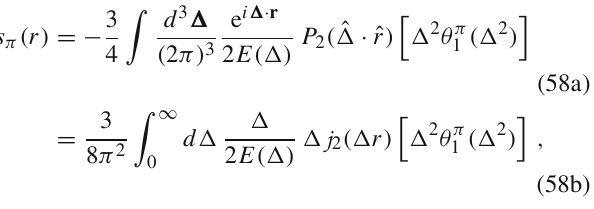
five-times larger than that in the proton; and (ii) the two pres- sure profiles have a similar radial extent. Notwithstanding the issues with Ref. [108] canvassed in Refs. [109,110], profiles analogous to Fig. 4 – upper panel for neutron stars indicate r (cid:7) 0 pressures therein of roughly 0 . 1 GeV/fm [111]; hence, the core pressures in the pion and neutron stars are commen- surate.